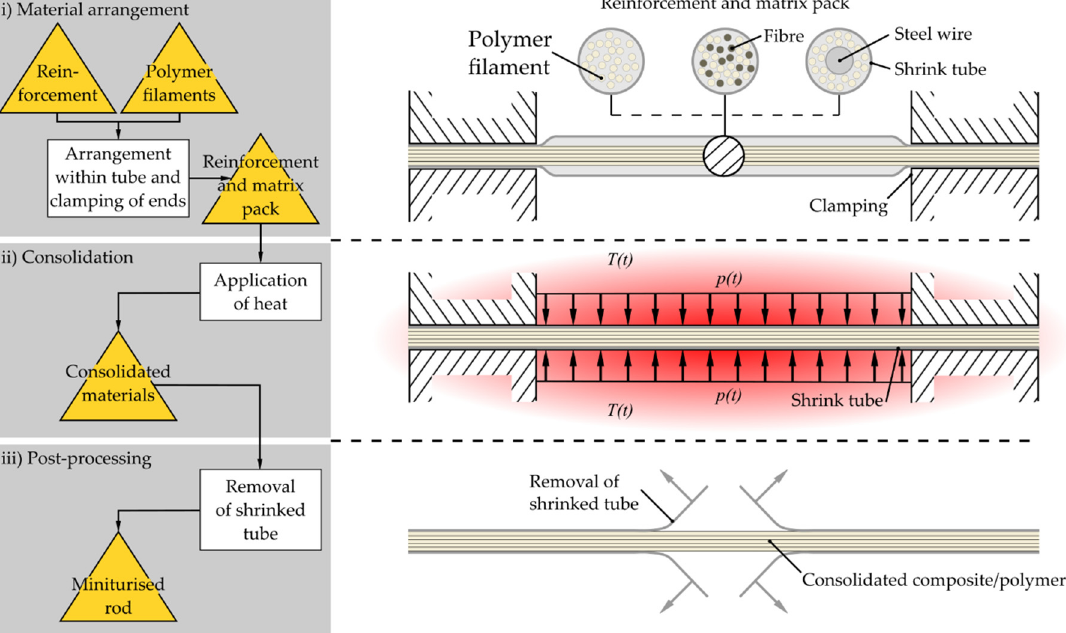
Figure 2. Process chain of shaping by compression of heat-shrinkable tube—shrink tube consolidation (STC): process diagram ( left ) and schematic of manufacturing steps ( right ).